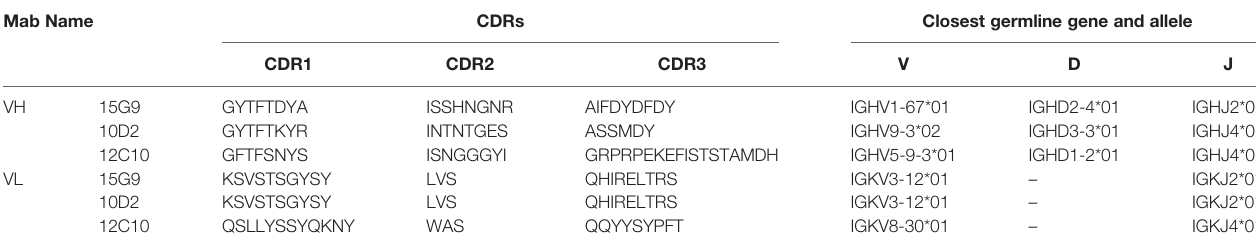
TABLE 3 | Sequence characteristics of the SARS-CoV-2 mAbs.